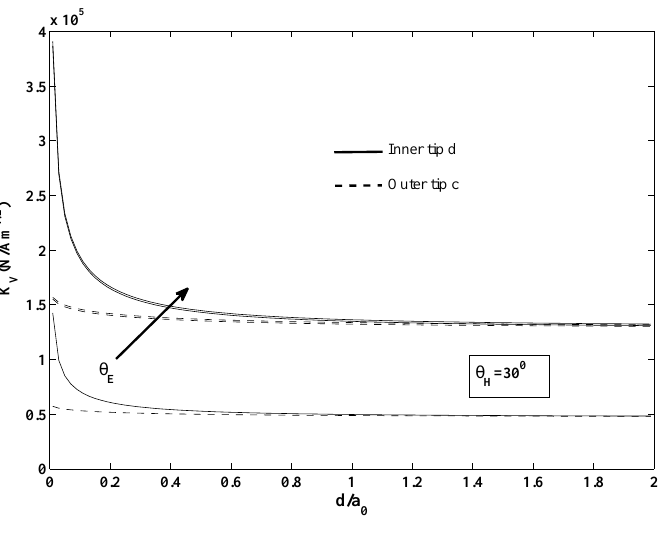
Fig. 9 MIIF versus inter-crack distance for different electric poling with fixed magnetic